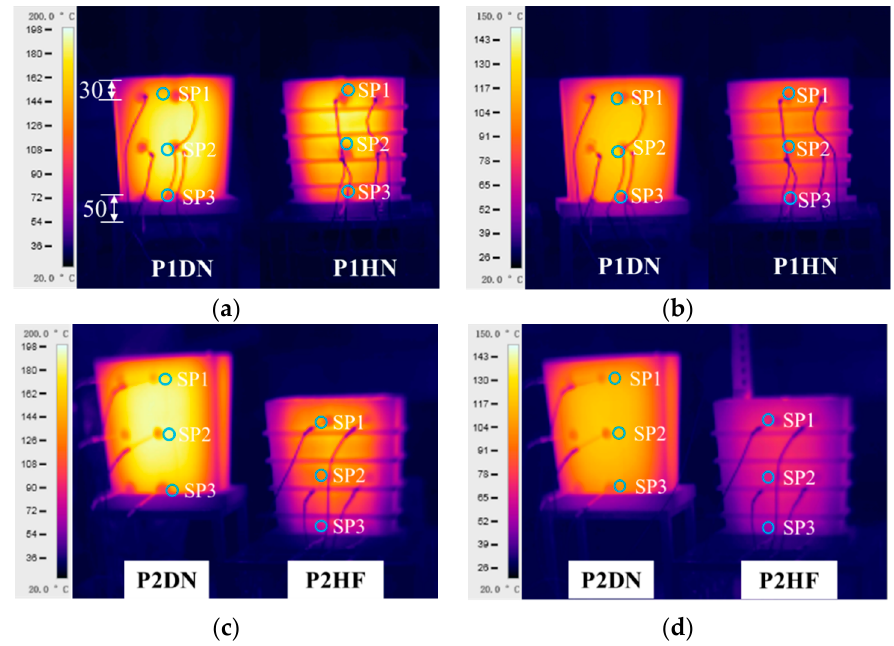
Figure 9. Infrared images of the sand mold during the casting process at ( a ) 2500 s, ( b ) 6000 s, ( c ) 2500 s, and ( d ) 6000 s.